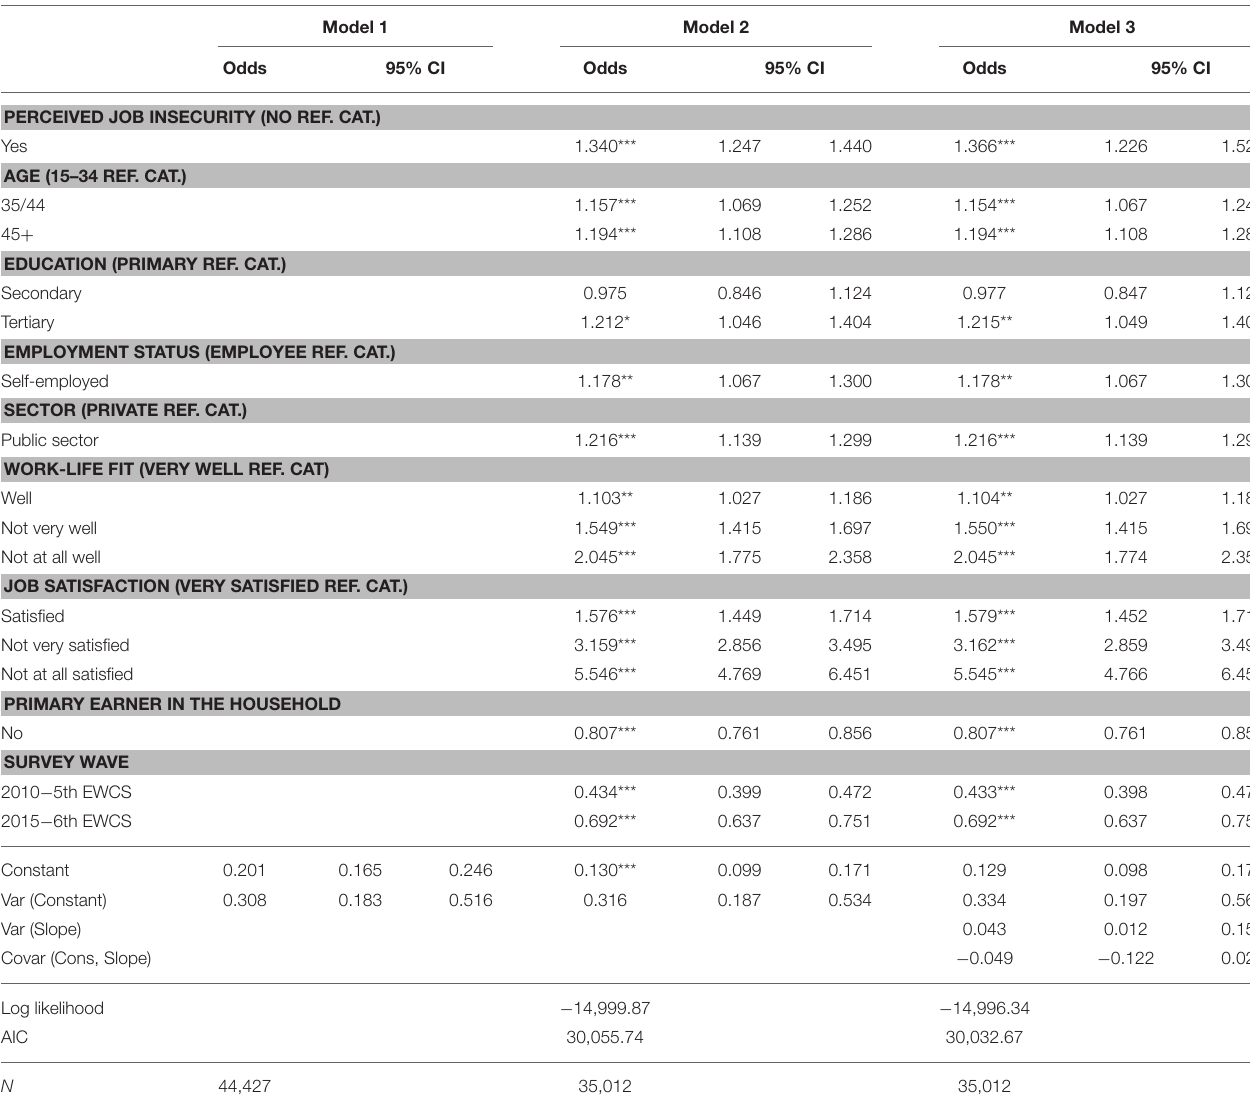
TABLE 2 | Results of mixed-effects logistic regression model (female